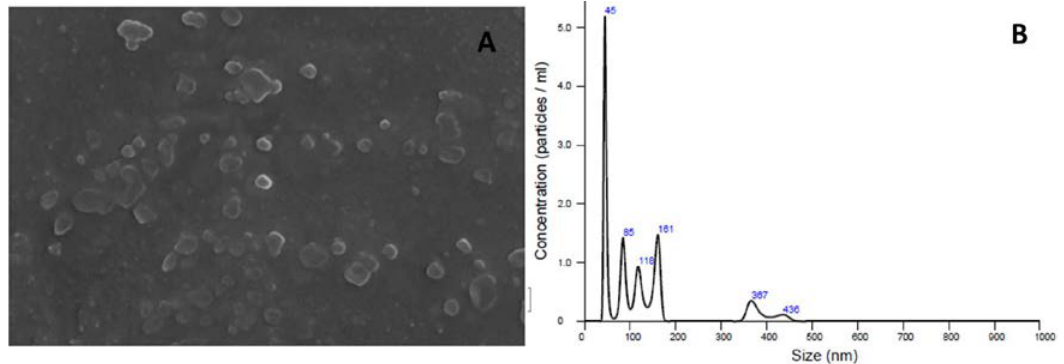
Figure 5. Scanning electron microscopy images (SEM) ( A ) and diagram of the distribution of the vesicles considering their size and concentration/mL ( B ).